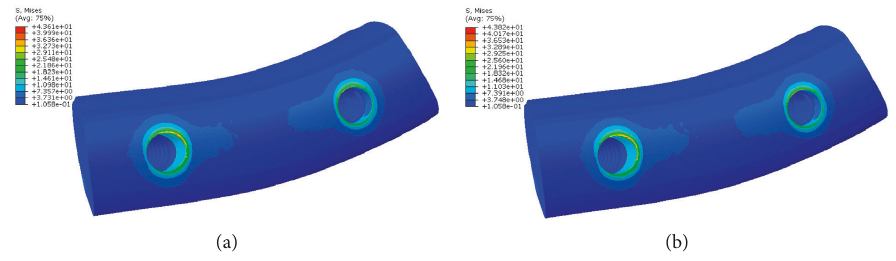
Figure 7: Stress distribution in bone in model 3. (a) PFBM. (b)